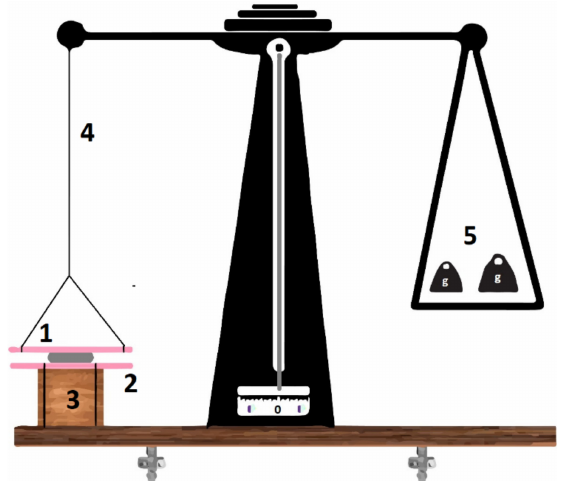
Figure 11. Experimental simulation of mucoadhesive strength tester as reported previously [31], where 1 = moveable glass slide with attached mucosa, 2 = attached mucosa to fixed glass slide to 3 = base, 4 = modified arm and 5 = weight added to the other